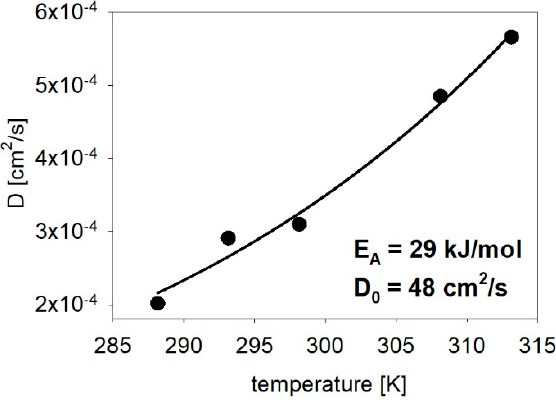
Figure 4. The temperature dependence of the calculated diffusion coefficient with the activation energy and pre-exponential factor values that were estimated from the Arrhenius equation.